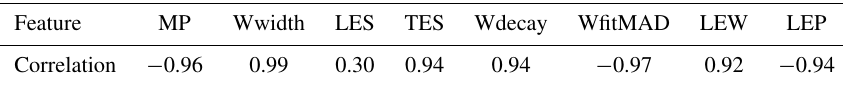
Table A3. Pearson linear correlation coefficients between features and thin-ice thickness (Fig. 7). Features: maximum power (MP), waveform width (Wwidth), LES (leading-edge slope), TES (trailing-edge slope), Wdecay (Waveform decay), WfitMAD (median absolute deviation of fitted waveform), LEW (leading-edge width), and LEP (leading-edge